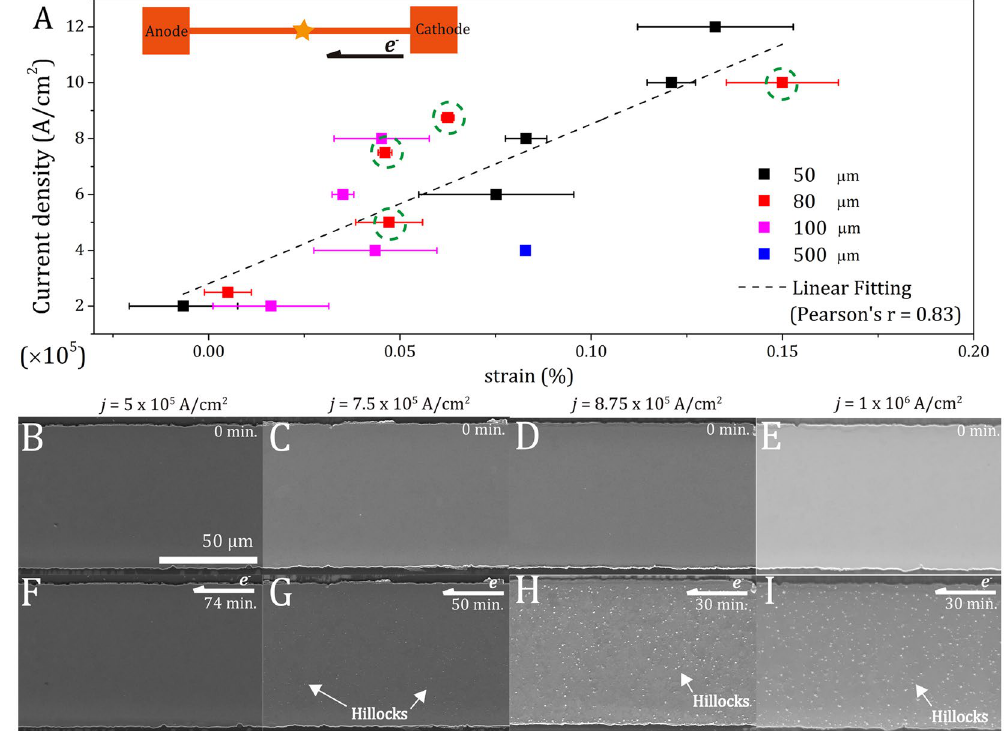
Figure 5. ( A ) The electron flow-induced strains of the 50, 80, 100, and 500 μ m-wide Cu strips under current stressing at various current densities. The Pearson correlation coefficient, r, for the linear fitting is 0.83. The SEIs of the 80 μ m-wide Cu strips ( B – E ) prior to current stressing and under current stressing at the current density of ( F ) 5.0 × 10 5 A/cm 2 for 74 min., ( G ) 7.5 × 10 5 A/cm 2 for 50 min., ( H ) 8.75 × 10 5 A/cm 2 for 30 min., and ( I ) 1.0 × 10 6 A/cm 2 for 30